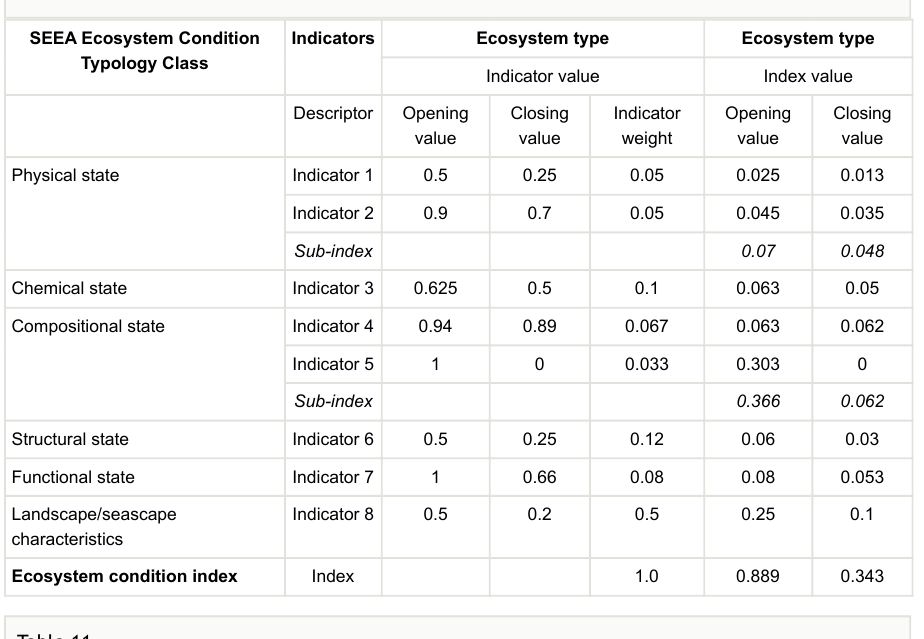
Ecosystem condition index account reported using re-scaled indicator values (‘mean values’ approach). (Numbers in cells are examples only and indicator weights were selected arbitrarily, but must sum to one.)